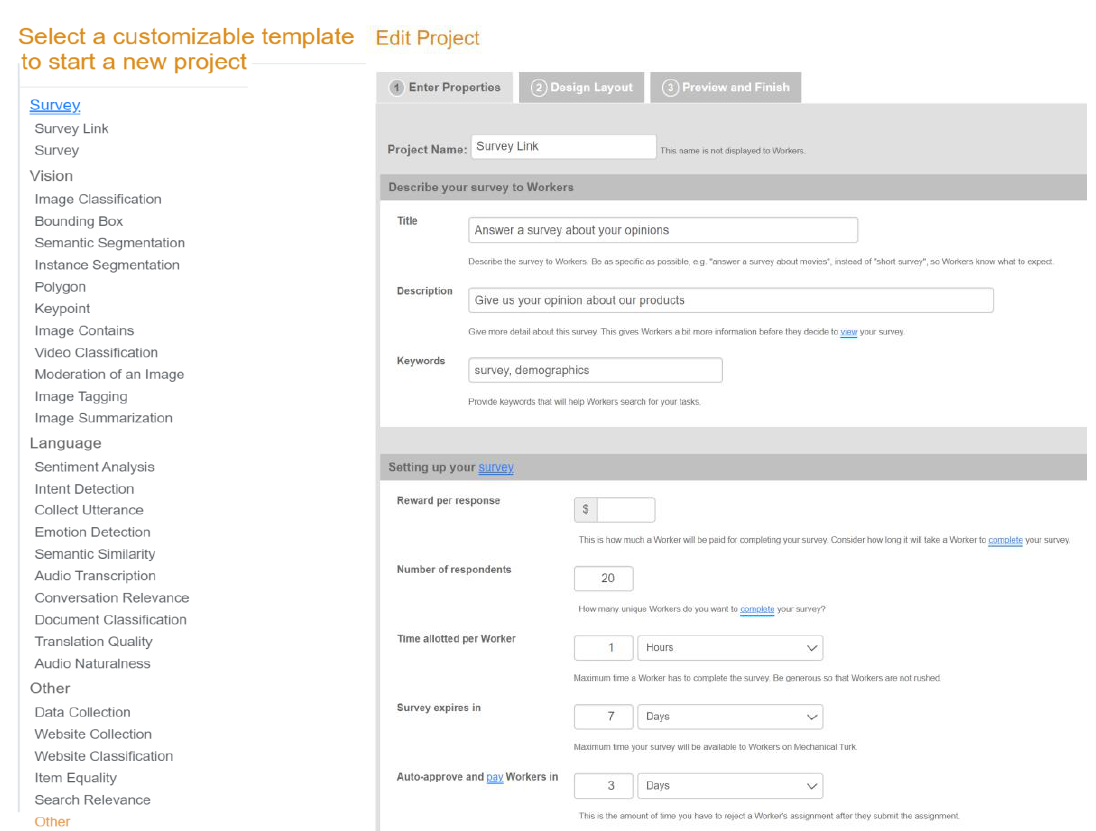
Figure 10. Client account in Amazon Mechanical Turk.